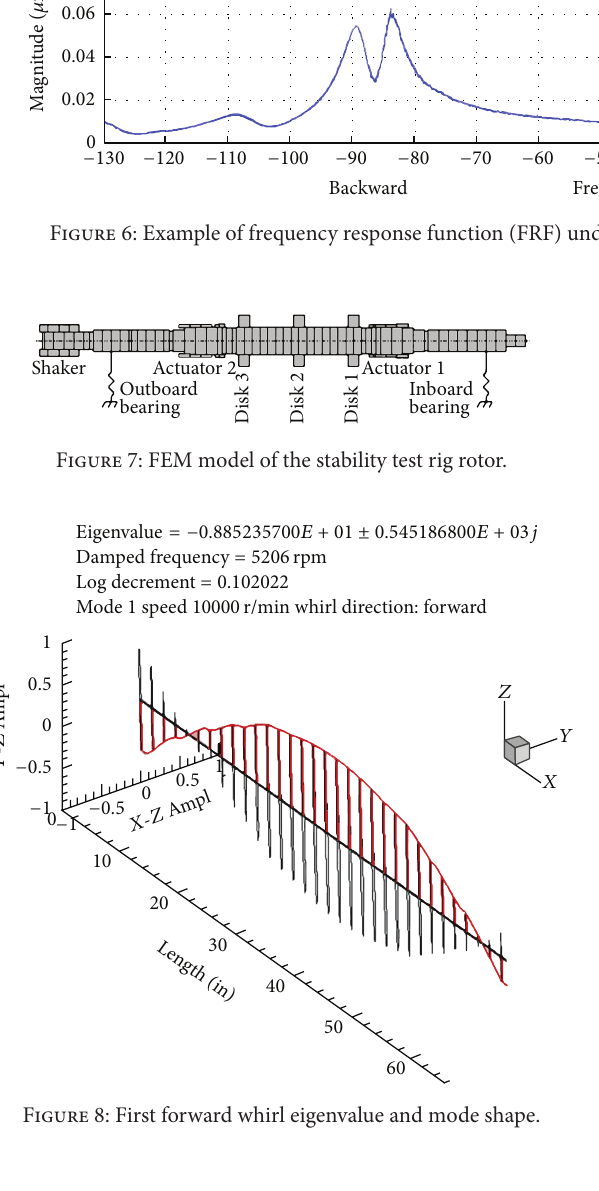
Figure 8: First forward whirl eigenvalue and mode shape.